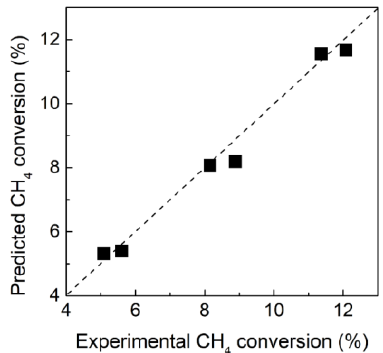
Figure 3. Comparison of experimentally obtained and theoretically predicted CH 4 conversions in the MR without H 2 extraction.